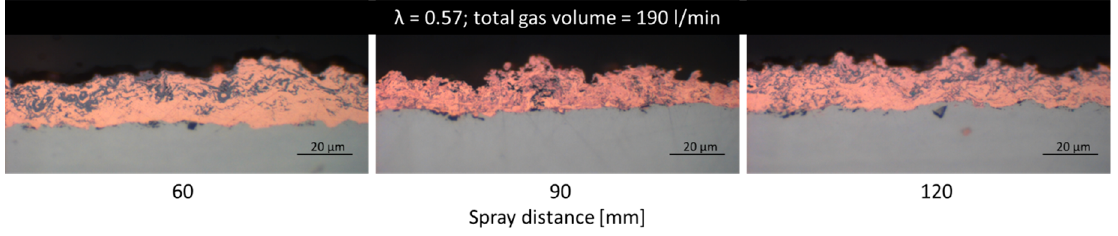
Figure 11. Comparison of coating thickness and roughness values of the Cu coatings sprayed at different spray distances and λ values.